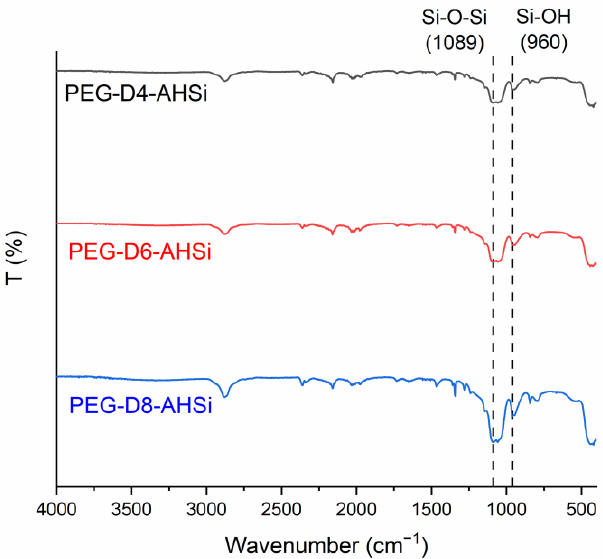
Figure 2. FTIR spectra of the composite adhesives chosen for the dermal wound repair.